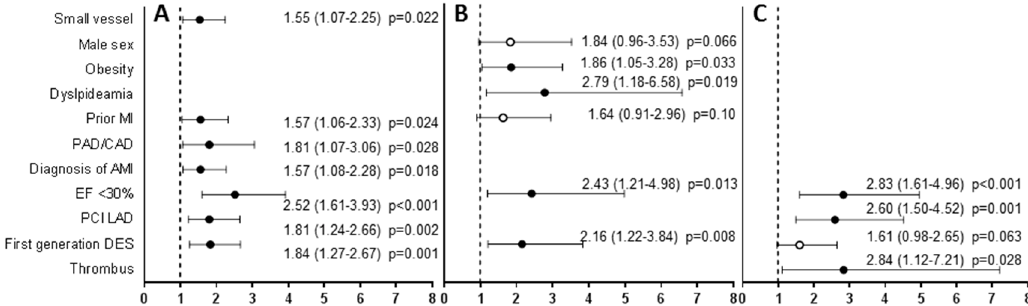
Figure 3. Multivariate Cox proportional hazard model for long-term MACCE in all patients ( A ), large vessels ( B ), small vessels ( C ). Data are presented as HR (95% CI). Full dots represent hazard ratio of statistically significant risk factors, empty dots represent hazard ratio of not statistically significant variables, bars represent 95% CI, dotted line shows HR = 1. MI—myocardial infarction, PAD/CAD— peripheral/carotid artery disease, EF—ejection fraction, PCI—percutaneous coronary intervention,